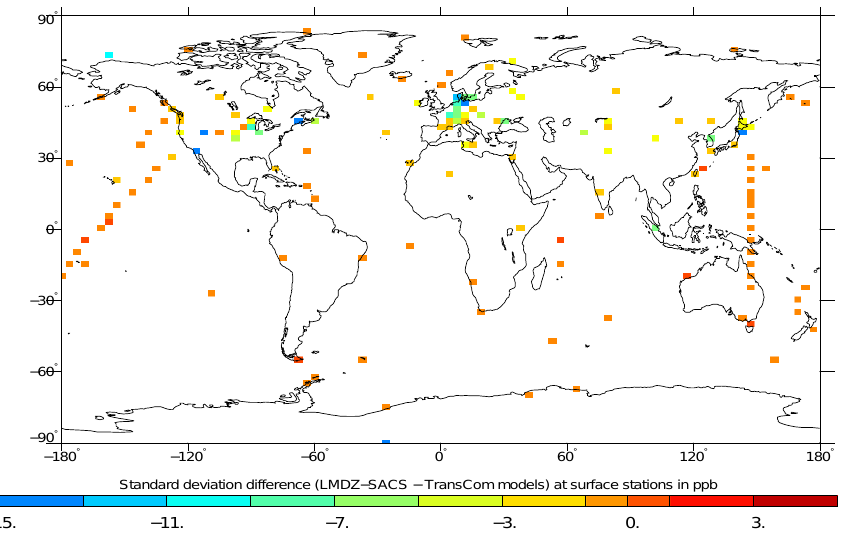
Fig. 4. Map of the differences in the “synoptic” standard deviation (STD) computed for CH 4 mixing ratio simulated by LMDZ-SACS and TransCom models at surface stations ( σ LMDZ-SACS − σ TransCom ; σ TransCom is the average of all TransCom models STD). The synoptic STD difference is expressed in